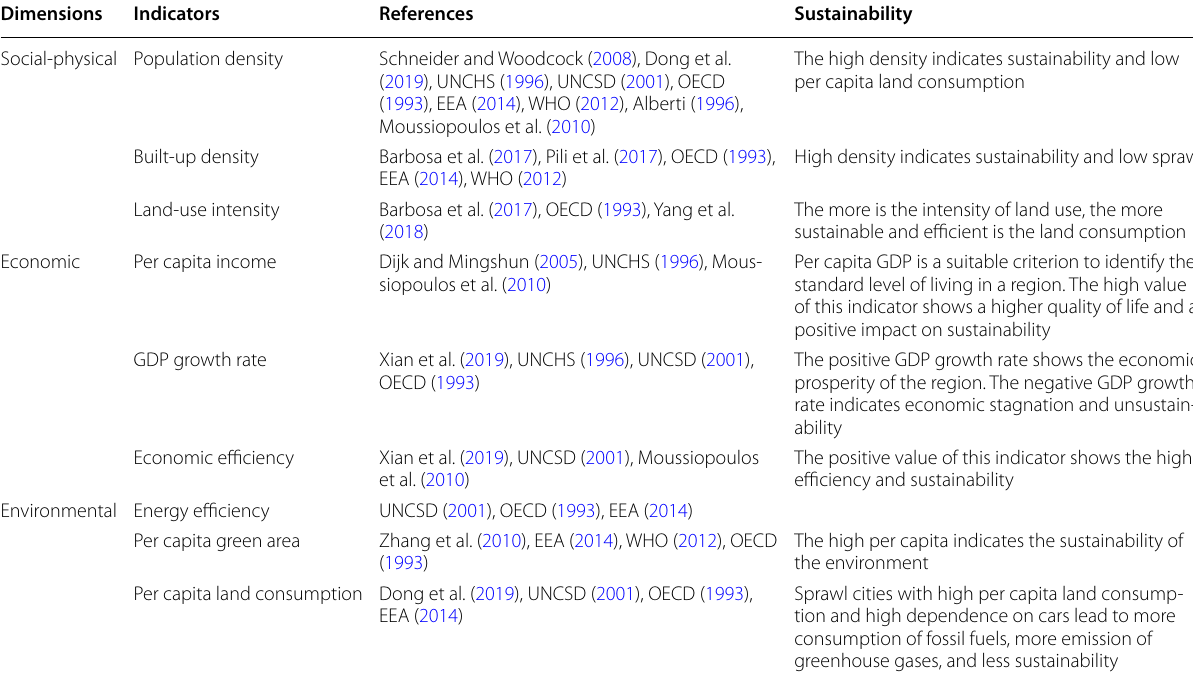
Table 4 Selected indicators for measuring the sustainability of land consumption patterns